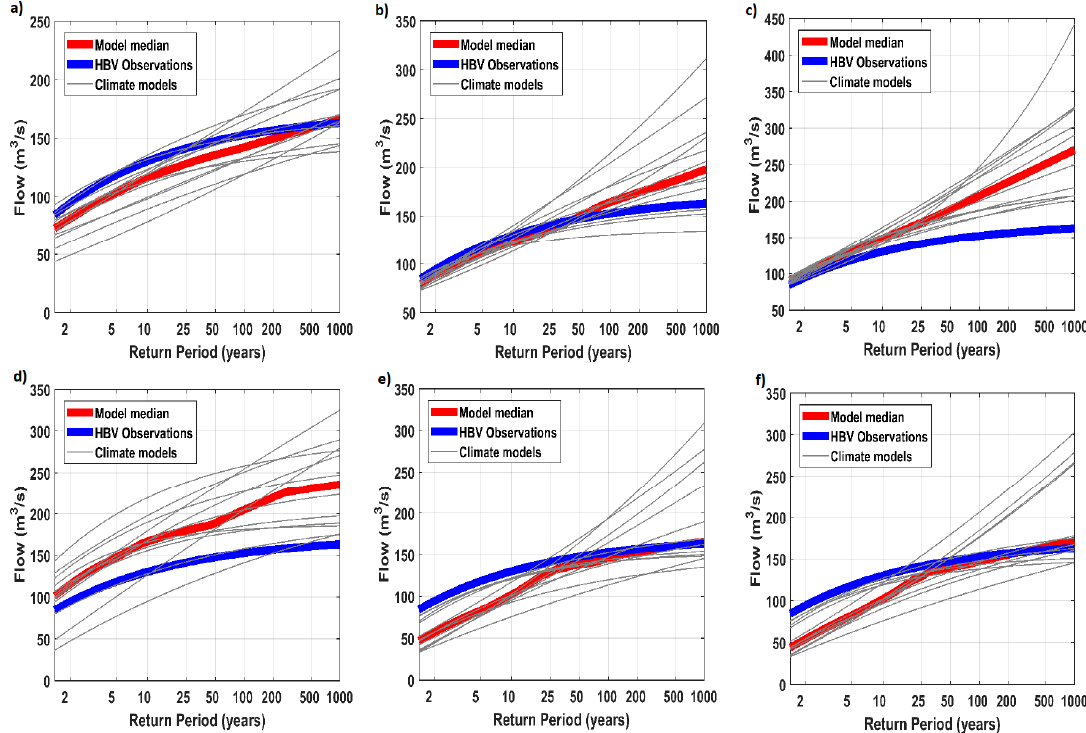
Figure 8. Comparison between flood frequency curves fitted to annual maximum series simulated by the HBV model with observed data and HBV simulations with climate projections in Barrios de Luna catchment, using a set of combinations of bias correction techniques. Red lines represent the median of the 12 climate models considered. ( a ) Raw data with no bias correction; ( b ) raw temperature and precipitation with quantile mapping (QM) linear correction; ( c ) raw temperature and precipitation with QM polynomial correction; ( d ) raw precipitation and temperature bias corrected; ( e ) temperature bias corrected and precipitation with QM linear correction; ( f ) temperature bias corrected and precipitation with QM polynomial correction.